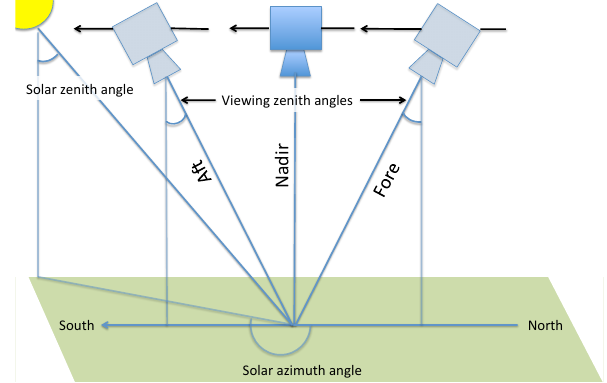
Fig. 1. Schematics of a generic multi-angle viewing mode using the satellite motion in low earth orbit instead of multiple spectrometers to record the same scene at various angles (similar to the OCO-2 target mode). Satellite viewing azimuth angles in this case are 0 ◦ and 180 ◦ for aft and fore viewing modes, respectively (angle with respect to the north-facing